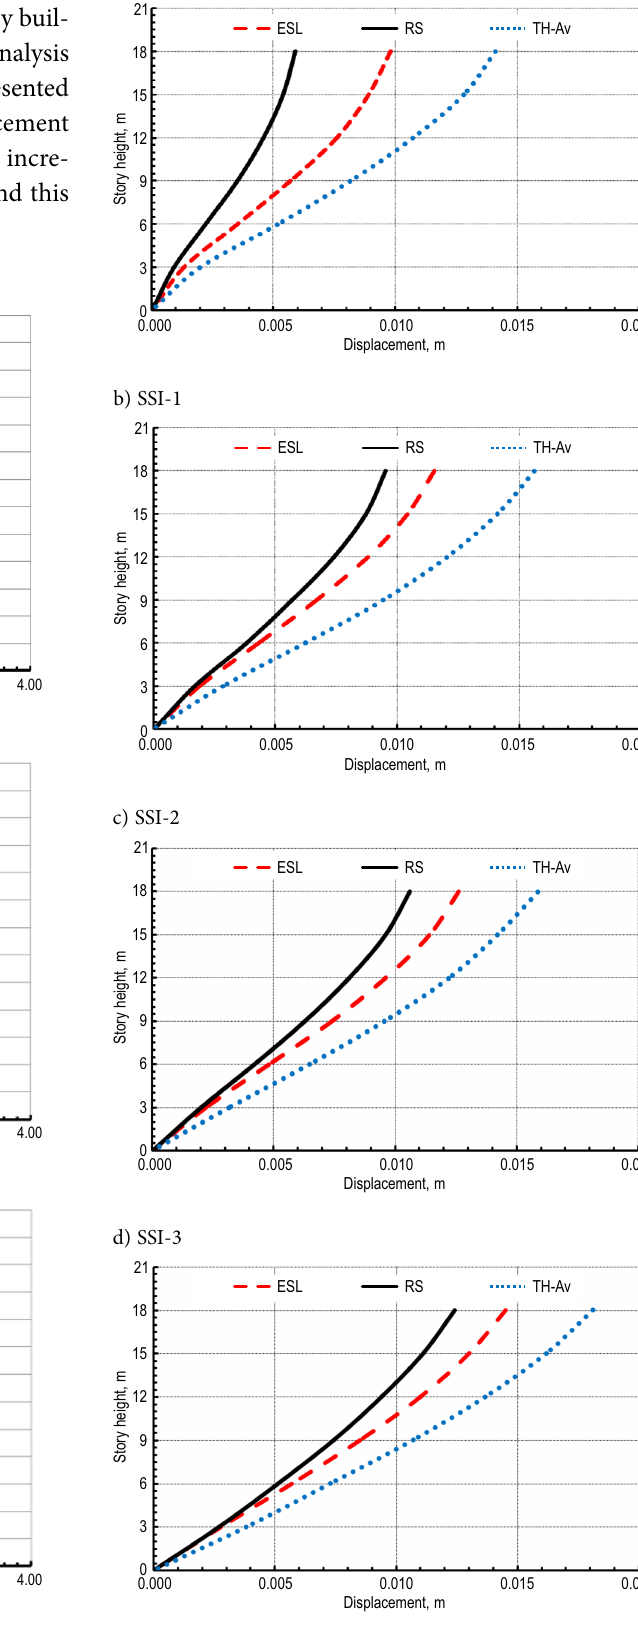
Fig. 8. Story lateral displacements of 6-story